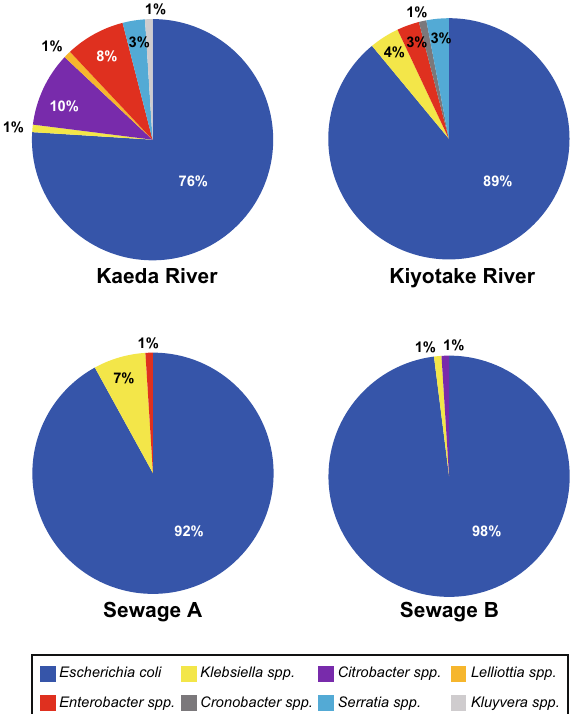
Figure 2. Proportions of E. coli and other identified species among the strains isolated from the water